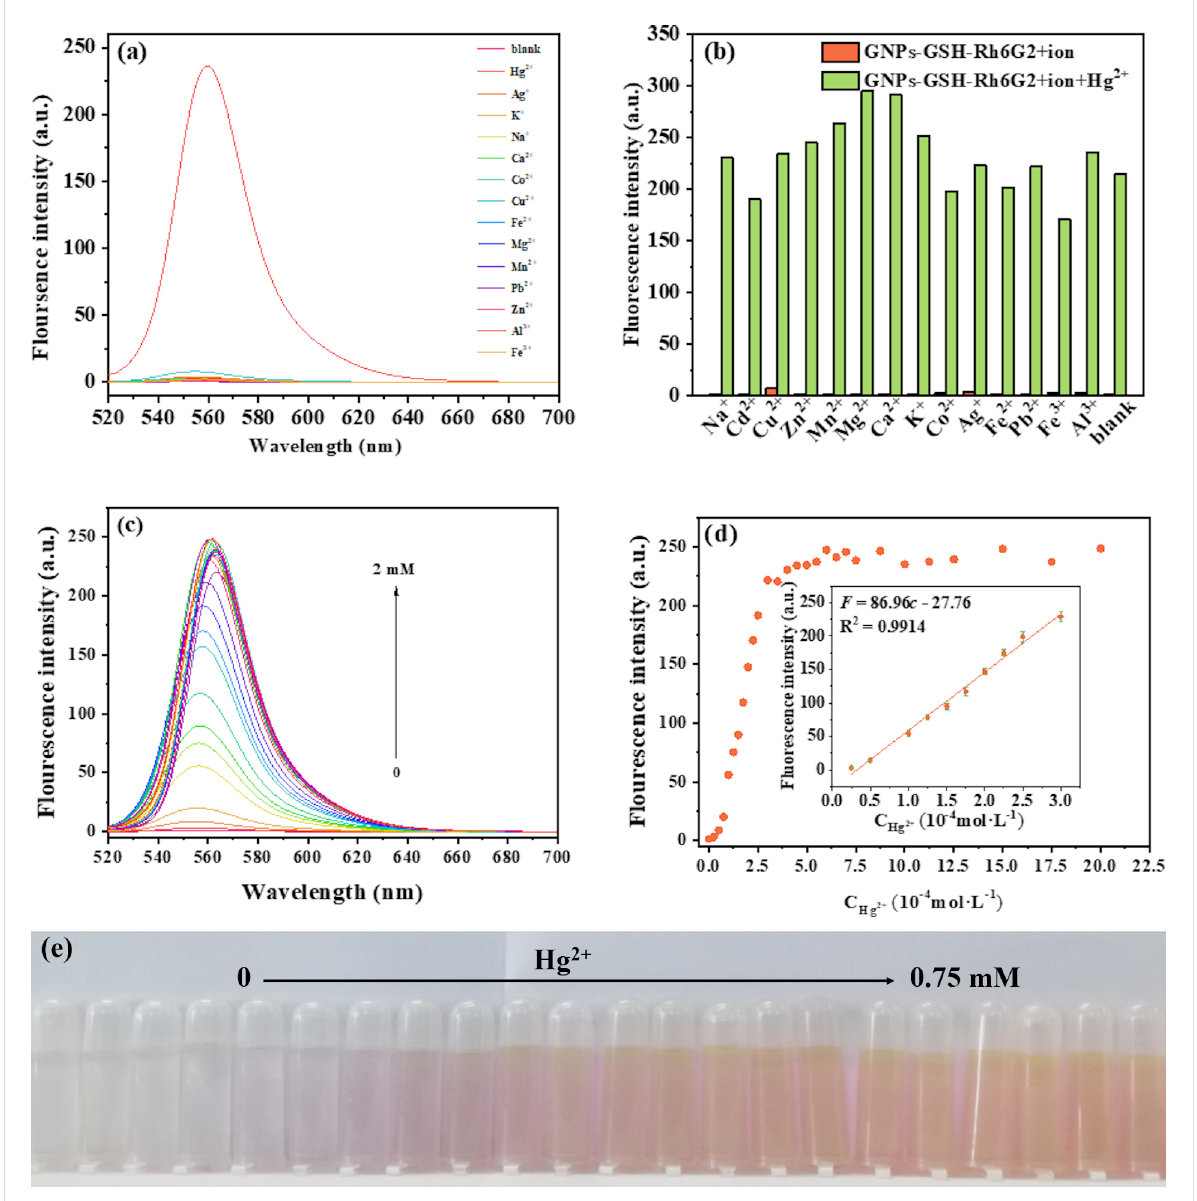
Figure 5: (a) Fluorescence spectra of GNPs-GSH-Rh6G2 with different ions (Hg 2+ , Na + , Cu 2+ , Zn 2+ , Mn 2+ , Mg 2+ , Ca 2+ , K + , Co 2+ , Ag + , Pb 2+ , Fe 3+ , and Al 3+ , concentration: 0.75 mM) in HEPES/CH 3 OH buffer (1:1 (v/v), 50 mM, pH 7); (b) fluorescence intensity at 560 nm of GNPs-GSH-Rh6G2 in the presence of Hg 2+ (0.75 mM) and different metal ions (0.75 mM); (c) fluorescence spectra of GNPs-GSH-Rh6G2 in HEPES/CH 3 OH buffer (1:1 (v/v), 50 mM, pH 7) exposed to different concentrations of Hg 2+ ; (d) fluorescence intensity at 560 nm as a function of the Hg 2+ concentration; (e) photographs of GNPs-GSH-Rh6G2 containing different amounts of Hg 2+